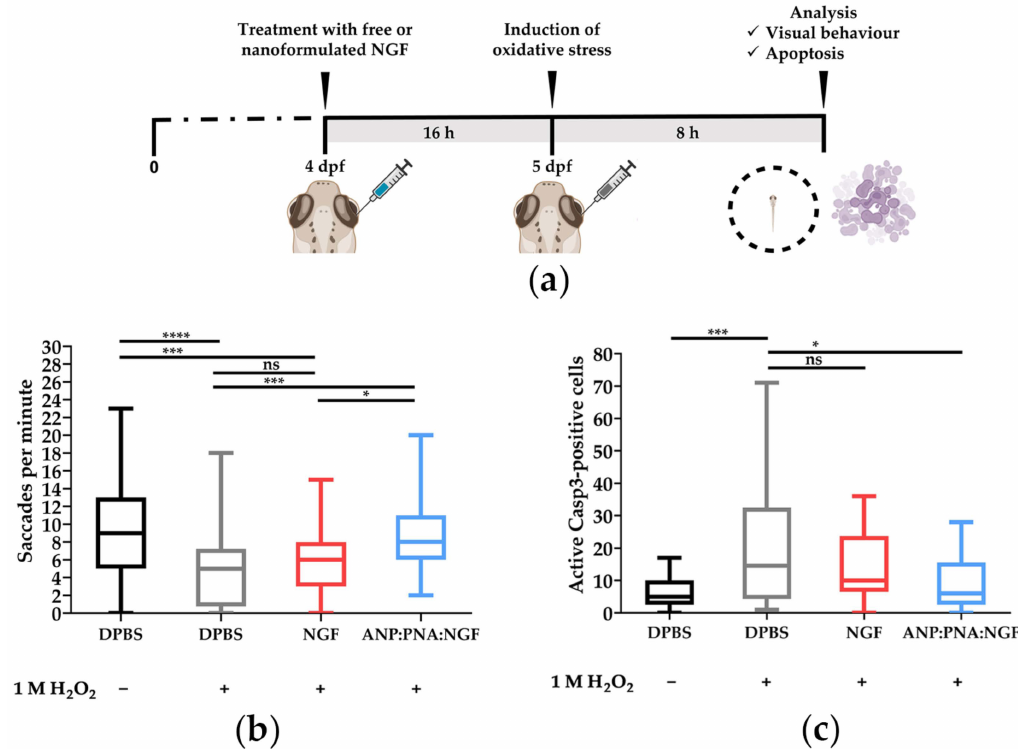
Figure 5. Nanoformulated NGF improves visual function impaired by oxidative stress in zebrafish larvae. ( a ) Experimental timeline relative to the intravitreal injection of free NGF or NGF bound to PNA-conjugated polyacrylamide nanoparticles (ANP:PNA:NGF) in zebrafish larvae at 4 days post-fertilisation (dpf), followed by H 2 O 2 exposure to induce oxidative stress in the retina. As control, zebrafish larvae were IVT injected with DPBS. ( b ) Evaluation of visual function by OKR assay in zebrafish larvae exposed to the treatments shown in panel ( a ). n ≥ 39 larvae for each group, Kruskal–Wallis followed by Dunn’s multiple comparisons test. ( c ) Quantitative evaluation of apoptosis through the detection of active caspase 3 (Casp3)-positive cells by immunofluorescence in zebrafish larvae exposed to the treatments shown in panel ( a ). n ≥ 20 larvae for each group, one-way ANOVA using Dunnett’s multiple comparisons test. ( b , c ) ns, p > 0.05; *, p < 0.01; ***, p < 0.001 and ****, p <